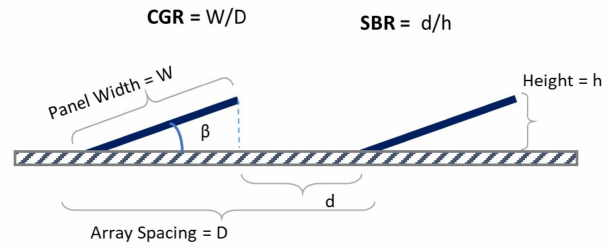
Figure 2. Profile view of Photovoltaic system layout on a flat roof illustrating the CGR (Coverage Ground Ratio) and SBR (Setback Ratio) [47],